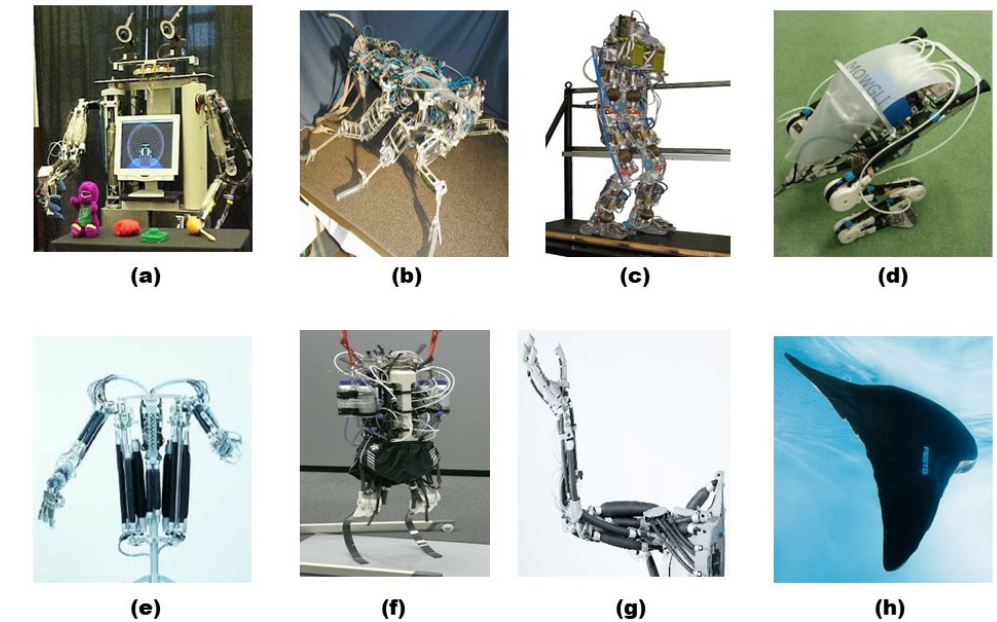
Figure 12. Biorobotic applications of PAMs: ( a ) ISAC [124]; ( b ) Ajax [129]; ( c ) Lucy [130]; ( d ) Mowgli [132]; ( e ) Zwei–Arm–Roboter [135]; ( f ) Pneumatic Athlete Robot [136]; ( g ) Airic’s robotic arm [105]; ( h ) Aqua ray robot [105]